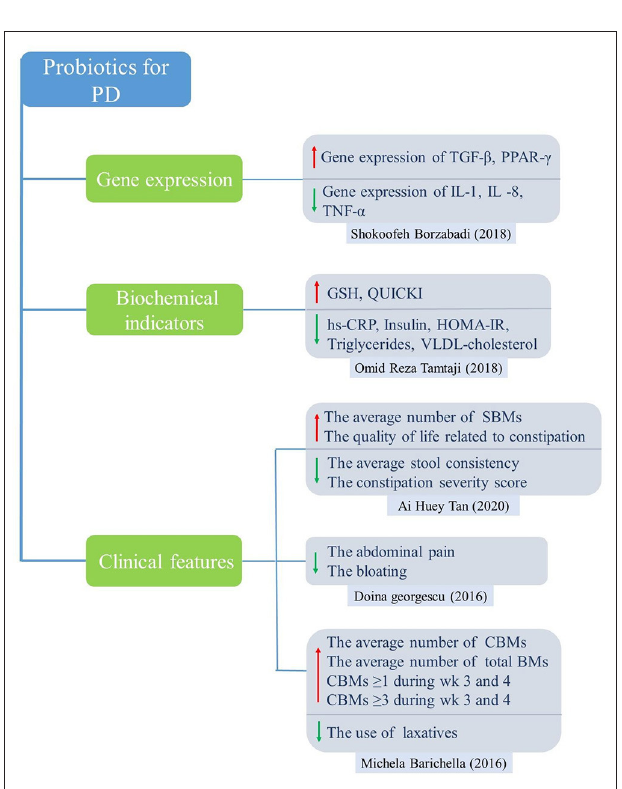
FIGURE 4 | Main findings of the effects of probiotics on patients with